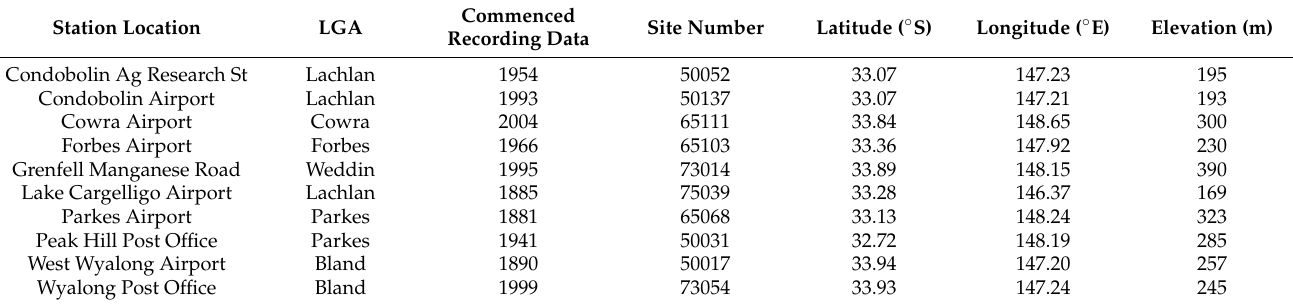
Figure 1. Australia’s NSW Central West region (Reprinted/adapted with permission from Ref. [36]. 2015, APCBSS). Table 1. Details of the study stations.